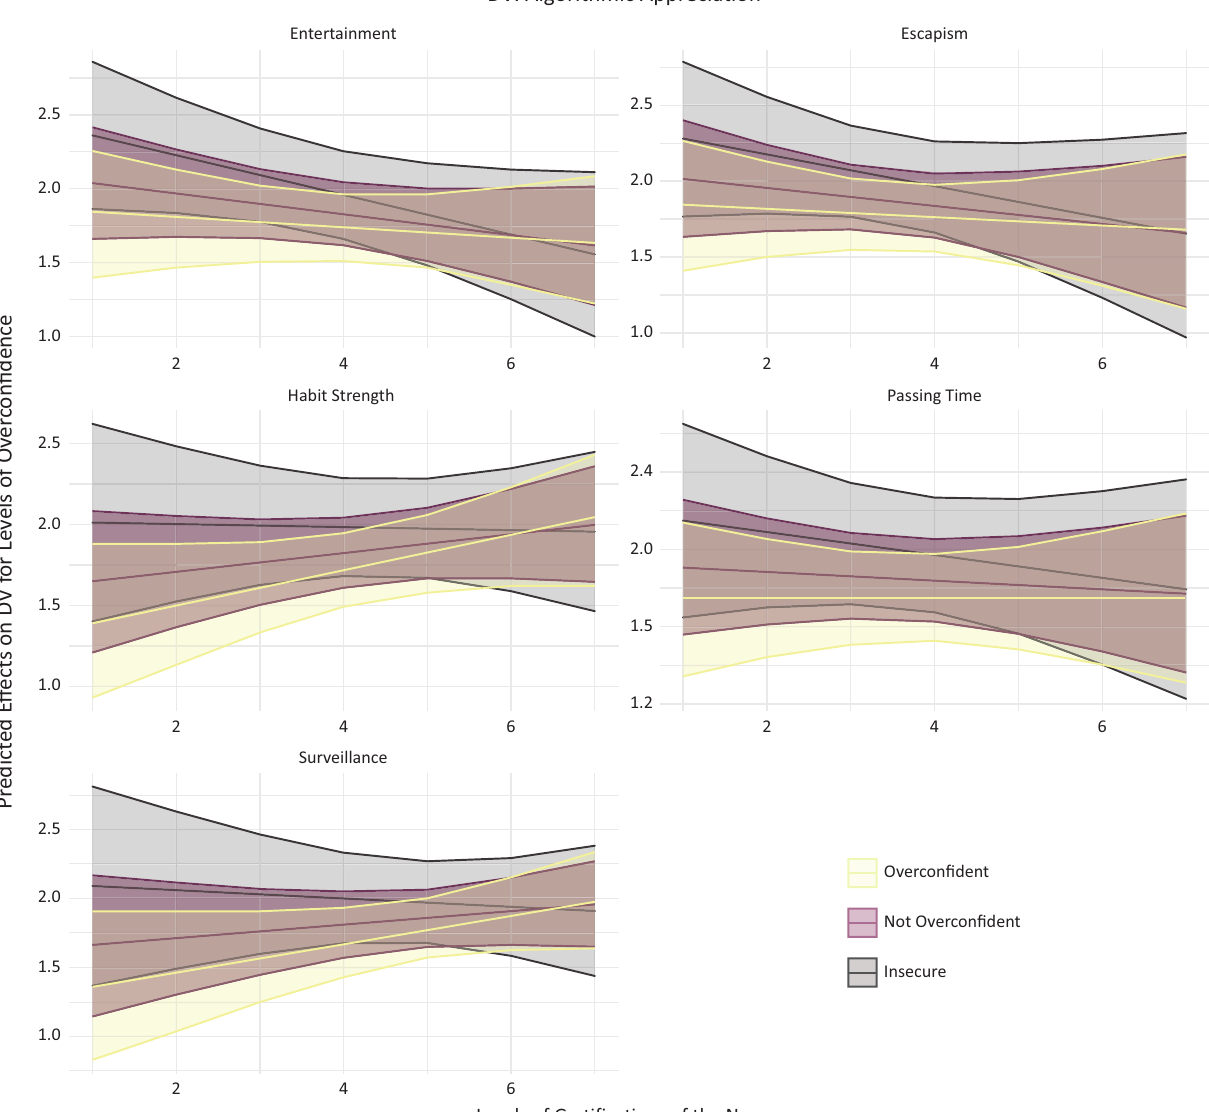
Figure 5. Predicting algorithmic appreciation for different levels of epistemic